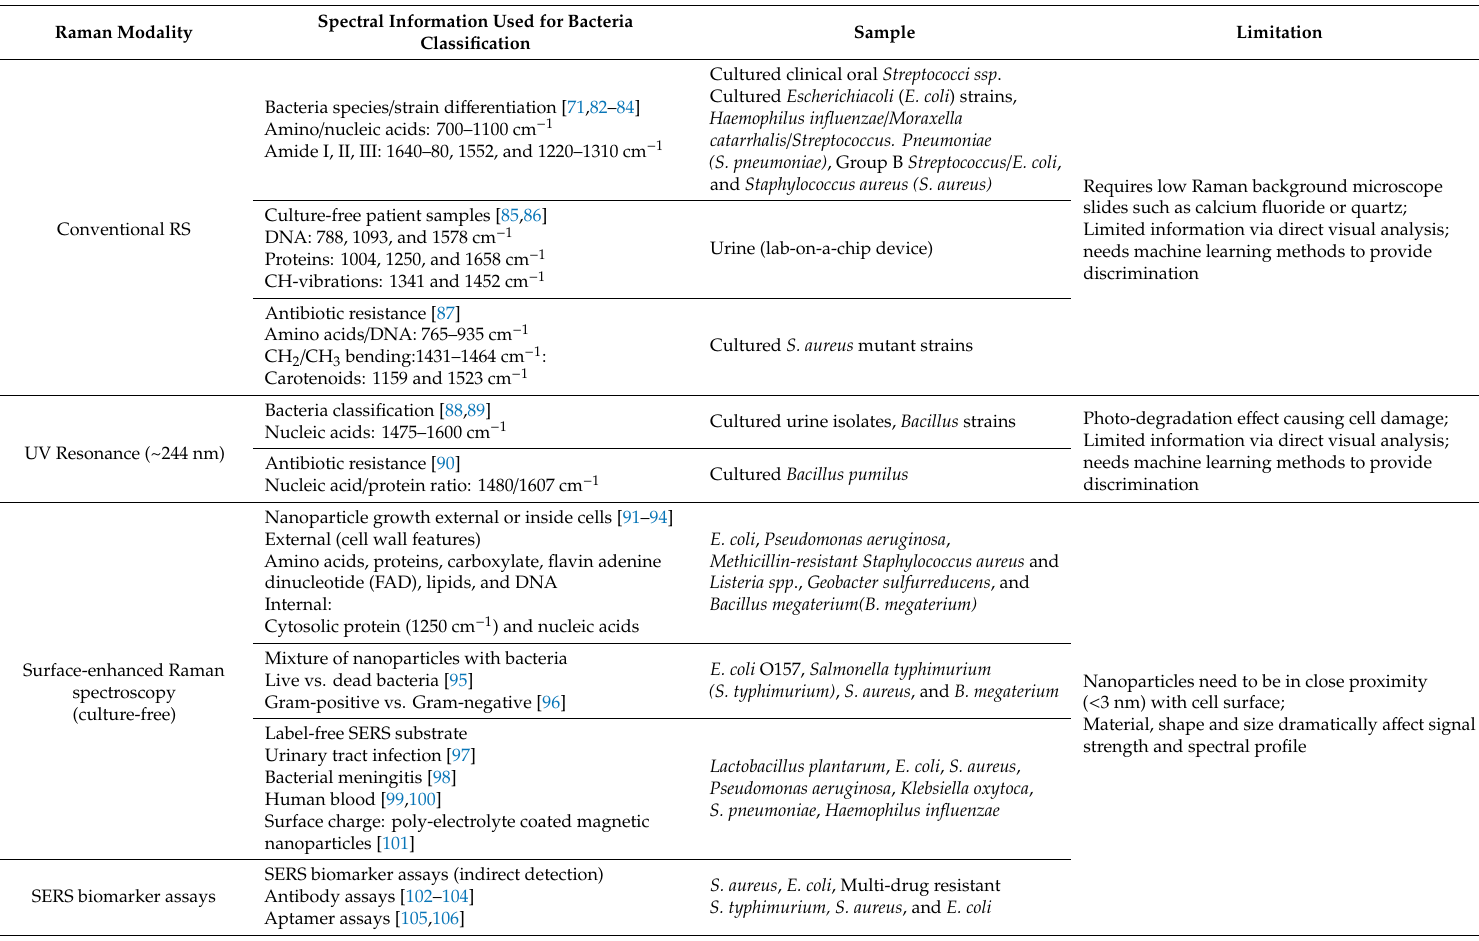
Table 2. Summary of work relating to Raman-based systems for bacterial detection. SERS: surface-enhanced Raman